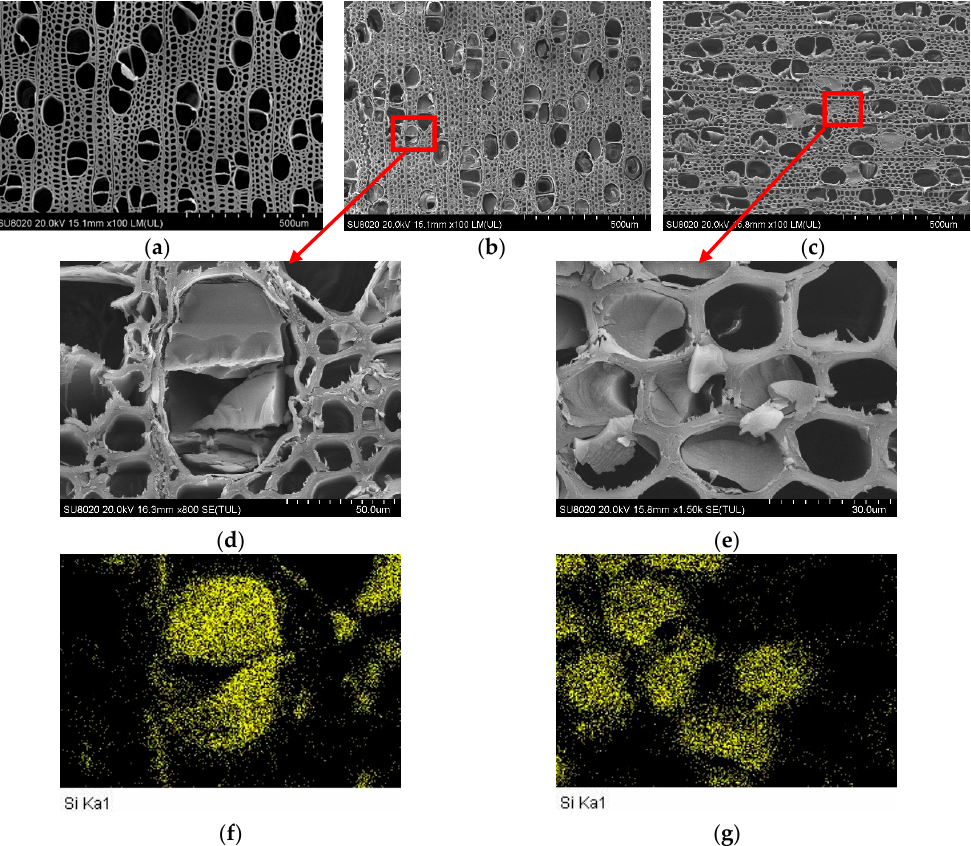
Figure 1. SEM and EDX images of untreated and modified wood. ( a ) cross-section of untreated wood, ( b ) cross-section of W-Si, ( c ) cross-section of W-Si/B, ( d ) magnifying of ( b ), ( e ) magnifying of ( c ), ( f ) silicon X-ray maps of ( d ), ( g ) silicon X-ray maps of ( e ).